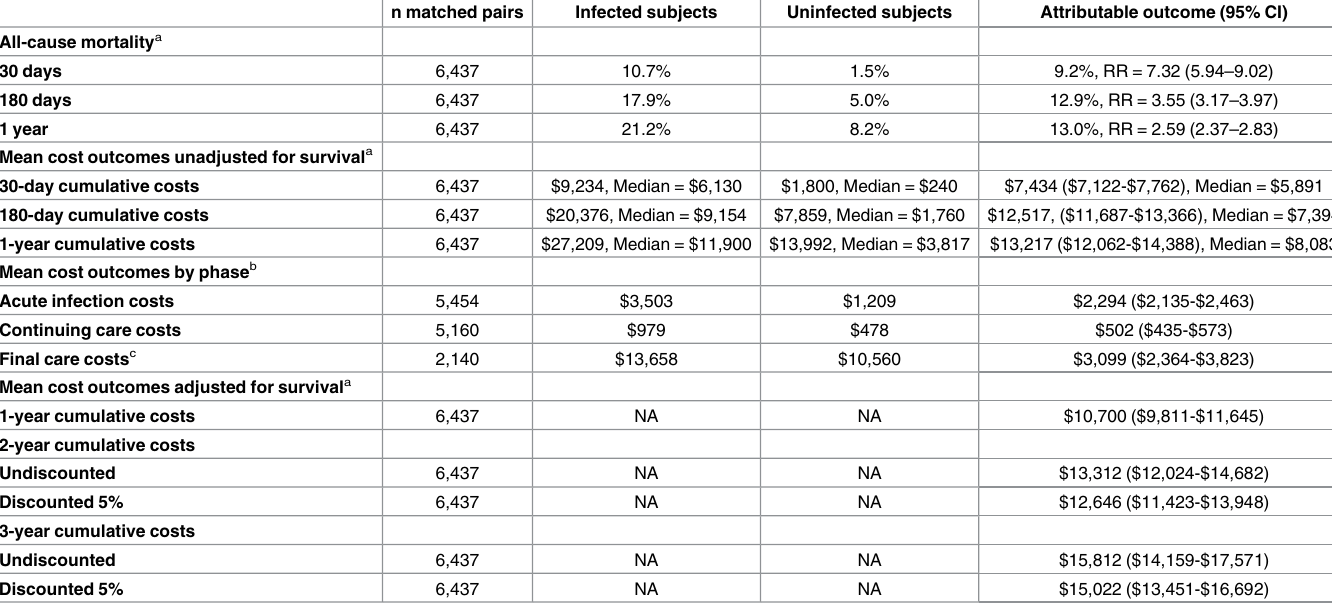
Table 3. All-cause mortality and healthcare costs attributable to community-onset CDI. n matched